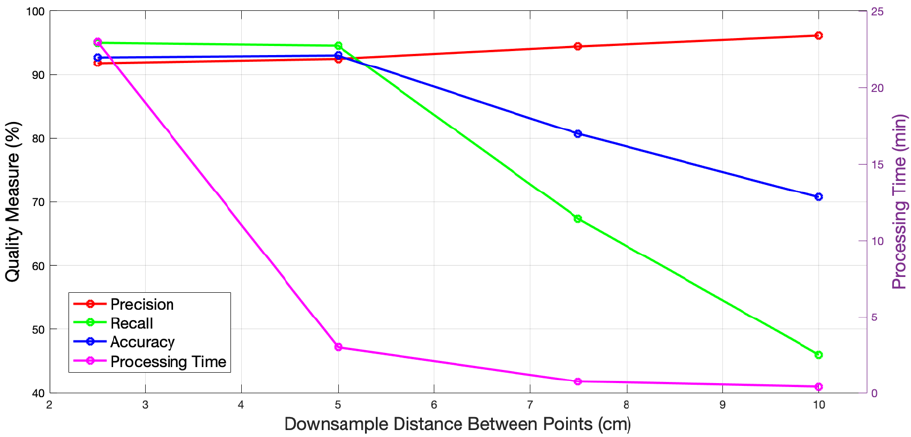
Figure 16. Results for various down sample distances (2.5 cm, 5 cm, 7.5 cm, and 10 cm) in the Signal House dataset.